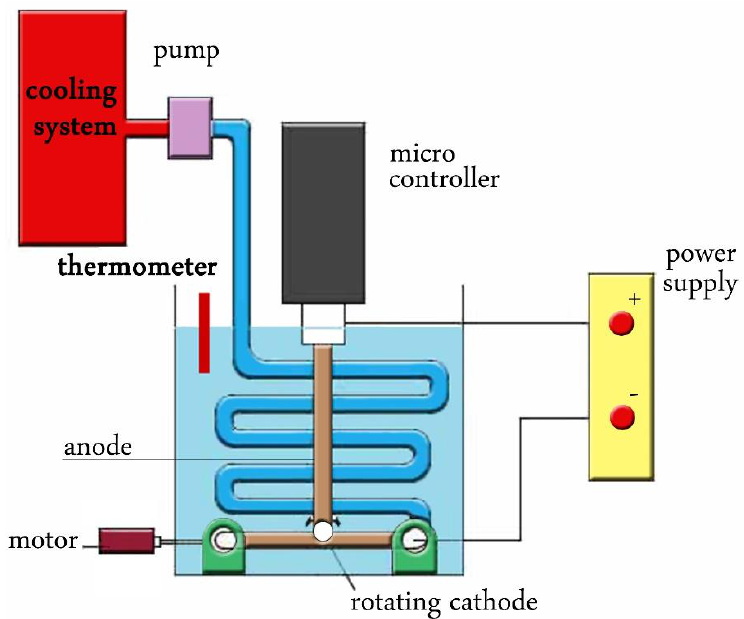
Figure 1. Arc-discharge machine